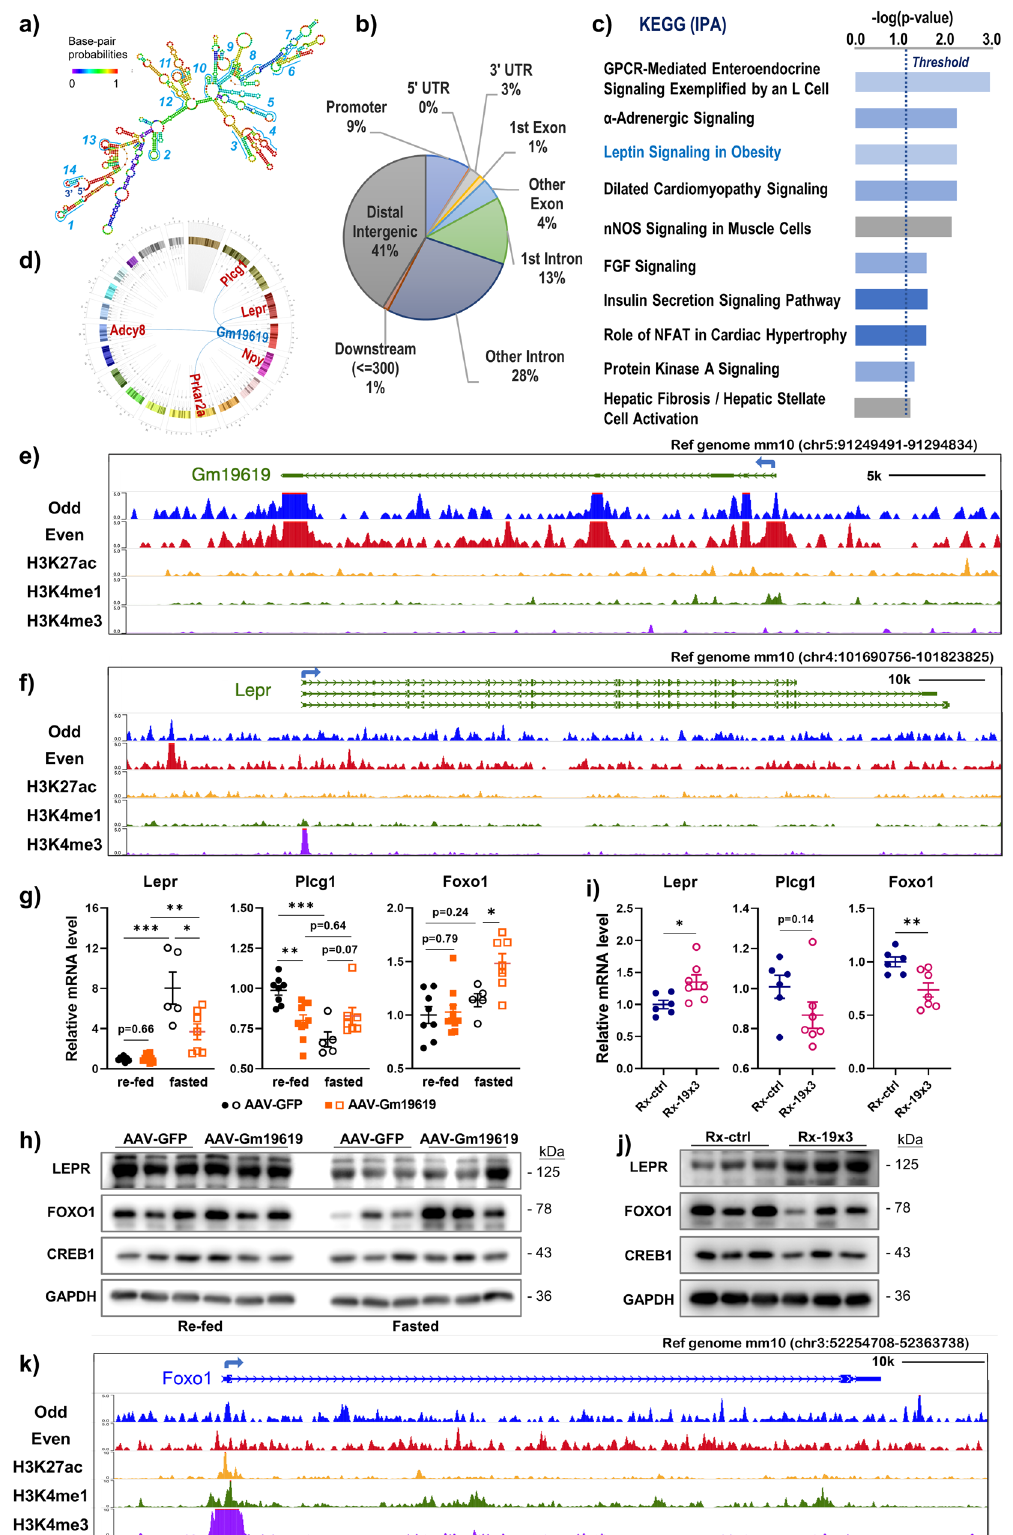
We used AAV-CasRx to knock down the hepatic RNA of Gm19619 . Compared with CRISPR-Cas9 mediated chromatin DNA disruption or CRISPRi mediated transcriptional repression 33 , CasRx will only bind and cut RNA 34 , without any interaction with chromatin DNA. CRISPR-Cas9 with a single guide RNA for gene knockout does not work for lncRNA, as a